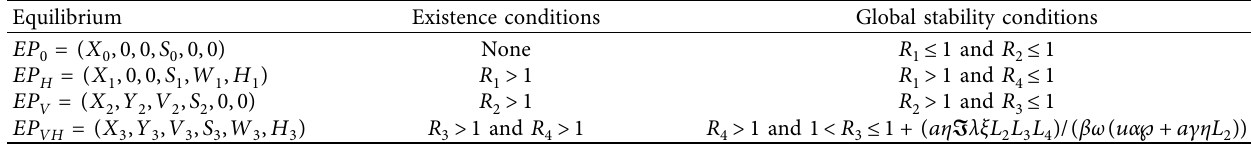
Table 1: Equilibrium points of model (2), existence conditions, and global stability conditions.